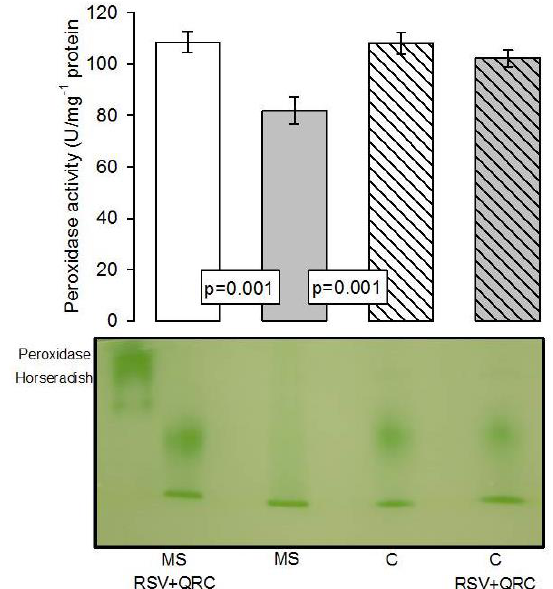
Figure 5. Densitophotometric analysis of the activities of peroxidases. A representative native gel is shown below the histogram. Under these conditions, where peroxidases are present, the gel remains transparent and the 3,3′,5,5′-tetramethylbenzidine is oxidized, showing a green coloration. Data are means ± SE, n = 8 each group. Abbreviations: MS = metabolic syndrome, C = control, RSV = resveratrol, QRC = quercetin.